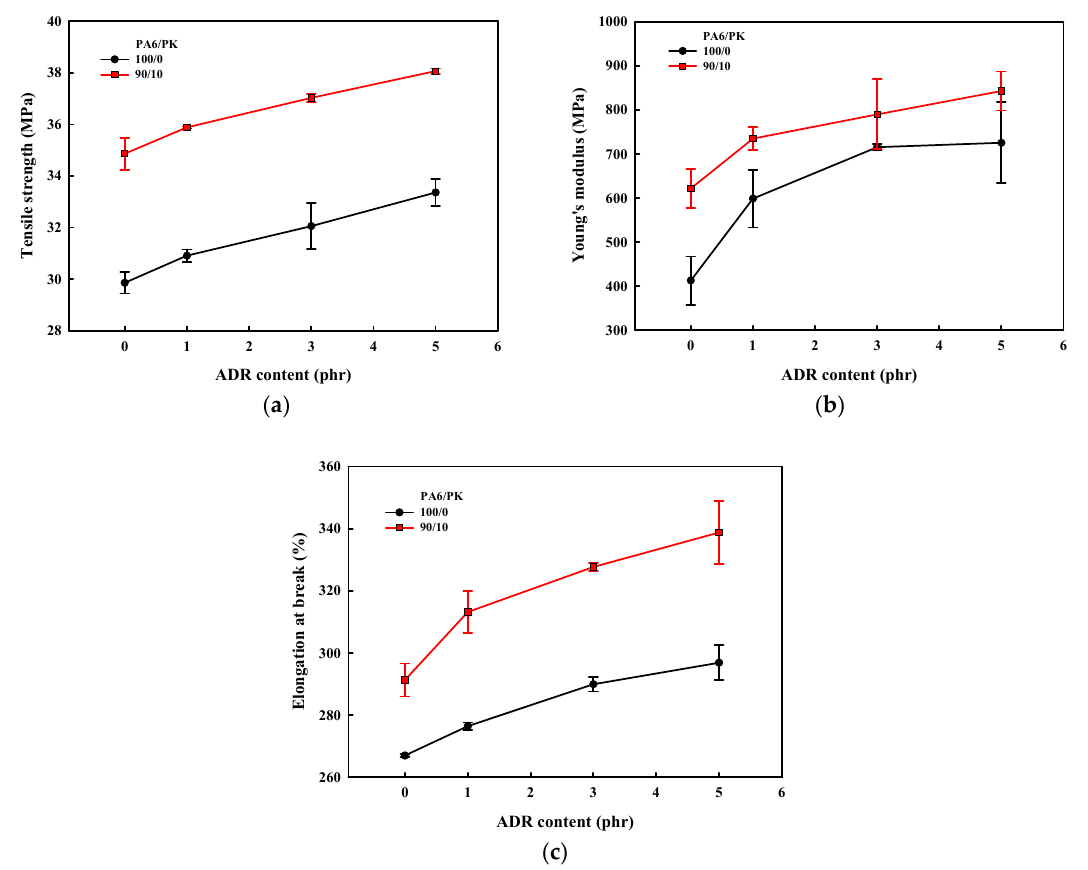
Figure 11. Effect of chain extender, ADR, content on the mechanical properties of PA6 and PA6/PK blends with chain extender, reflecting the influence of chain branching: ( a ) tensile strength; ( b ) Young’s modulus; ( c ) elongation at